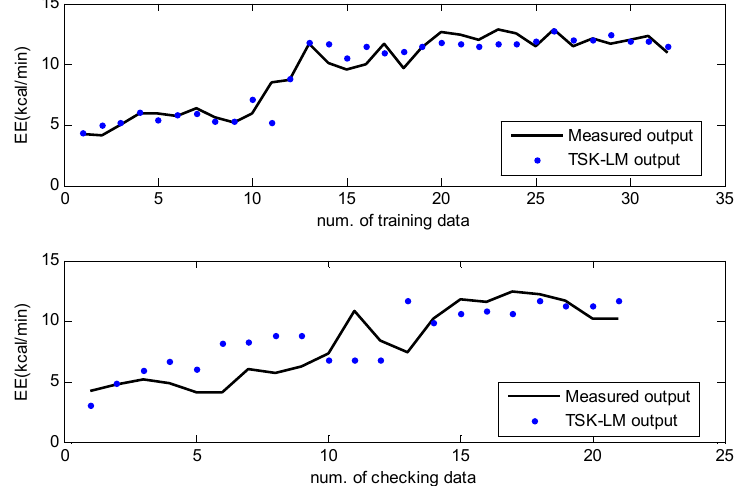
Figure 12. Approximation and generalization capability for brisk walking data.